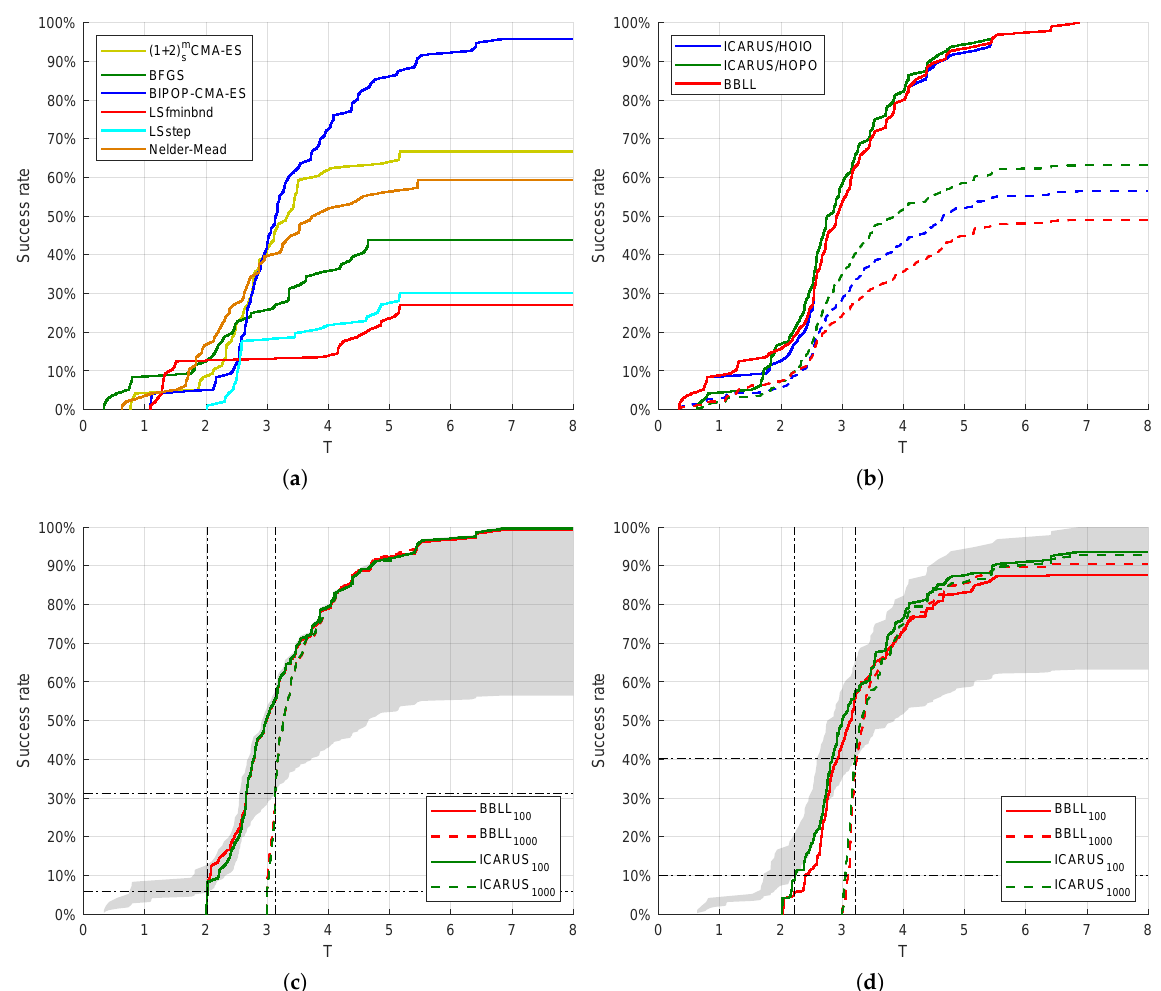
Figure 6. Performance of the methods from Table 3 in terms of SR against (cid:98) T . Figure ( a ) illustrates the performance of the individual algorithms, Figure ( b ) of the oracles and random selectors, Figure ( c ) of the selectors during HOIO, and Figure ( d ) of the selectors during HOPO. For the latter two figures, solid lines represent oracles using n / D = 100, while dashed lines represent oracles using n / D = 1000. The shaded region indicates the theoretical area of performance, with the upper bound representing the ICARUS oracle and the lower bound random